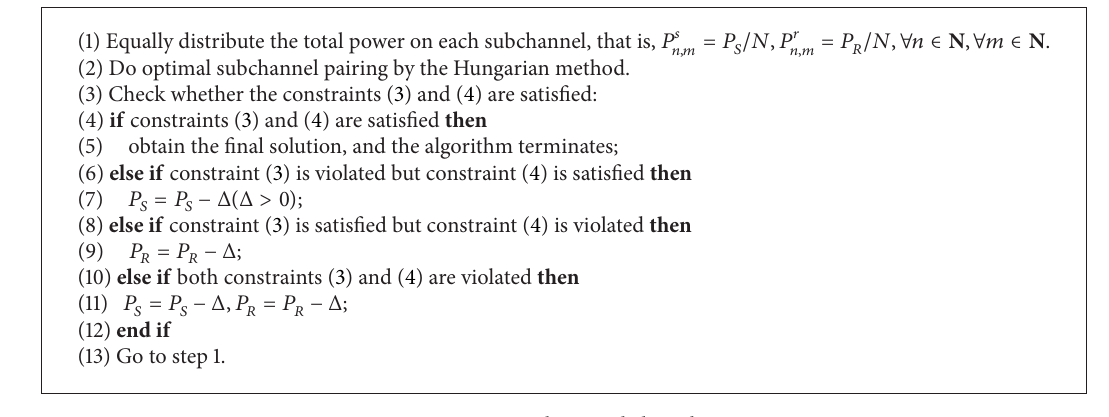
Algorithm 4: Suboptimal algorithm 2.